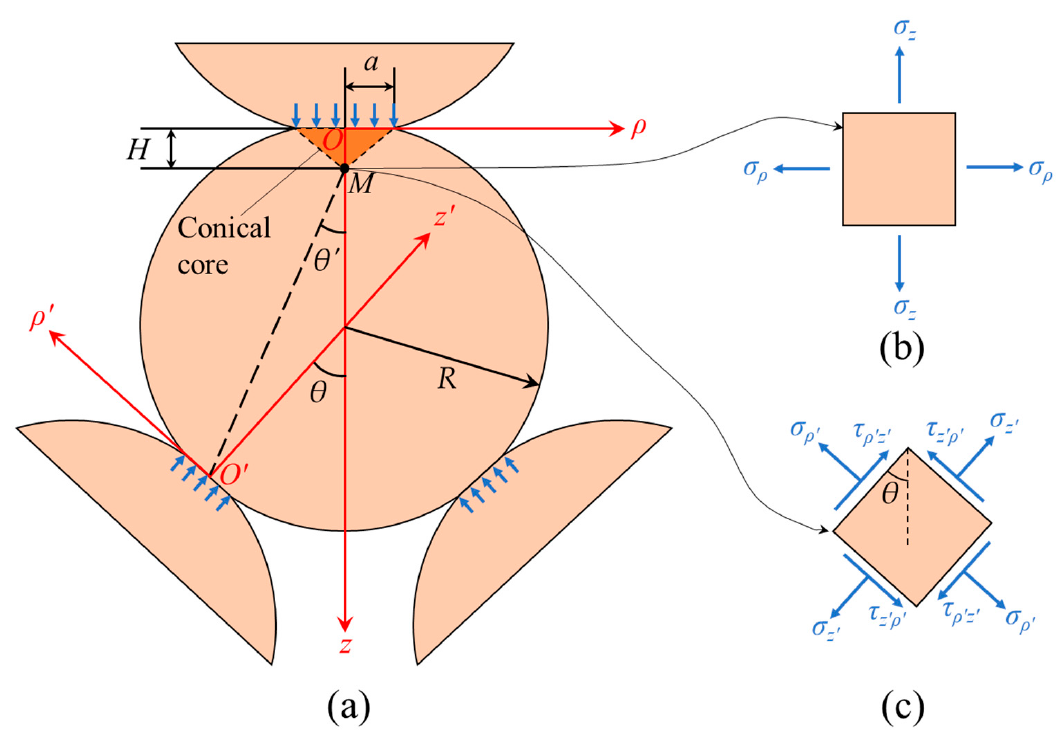
Figure 4. ( a ) Cylindrical coordinates ρ ~ φ ~ z for the contact point between Particles I and II; cylindrical coordinates ρ′ ~ φ′ ~ z ′ for the contact point between Particles I and III. ( b ) Stress state at point M caused by F . ( c ) Stress state at point M caused by F ′ . The φ -axis, φ′ -axis, σ φ , and σ φ ′ are not shown, as they are all perpendicular to the paper.